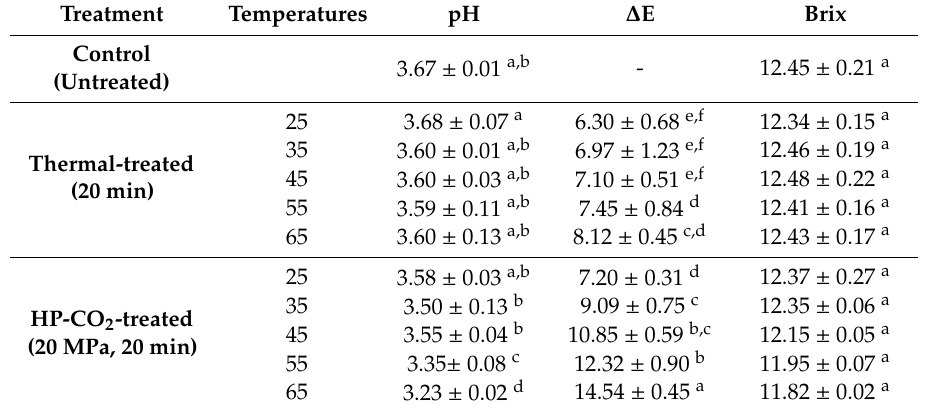
Table 1. pH and brix of apple juice from thermal and high-pressure carbon dioxide (HP-CO 2 ) treatments.